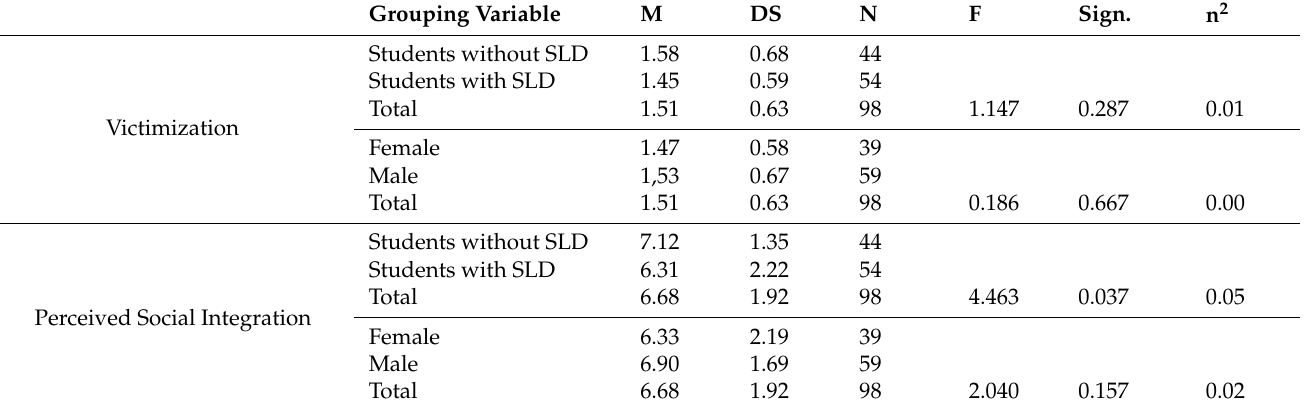
Table 2. Analyses of covariance (ANCOVAs): differences in mean scores in peer victimization and perceived social integration according to the presence/absence of Specific Learning Disabilities and